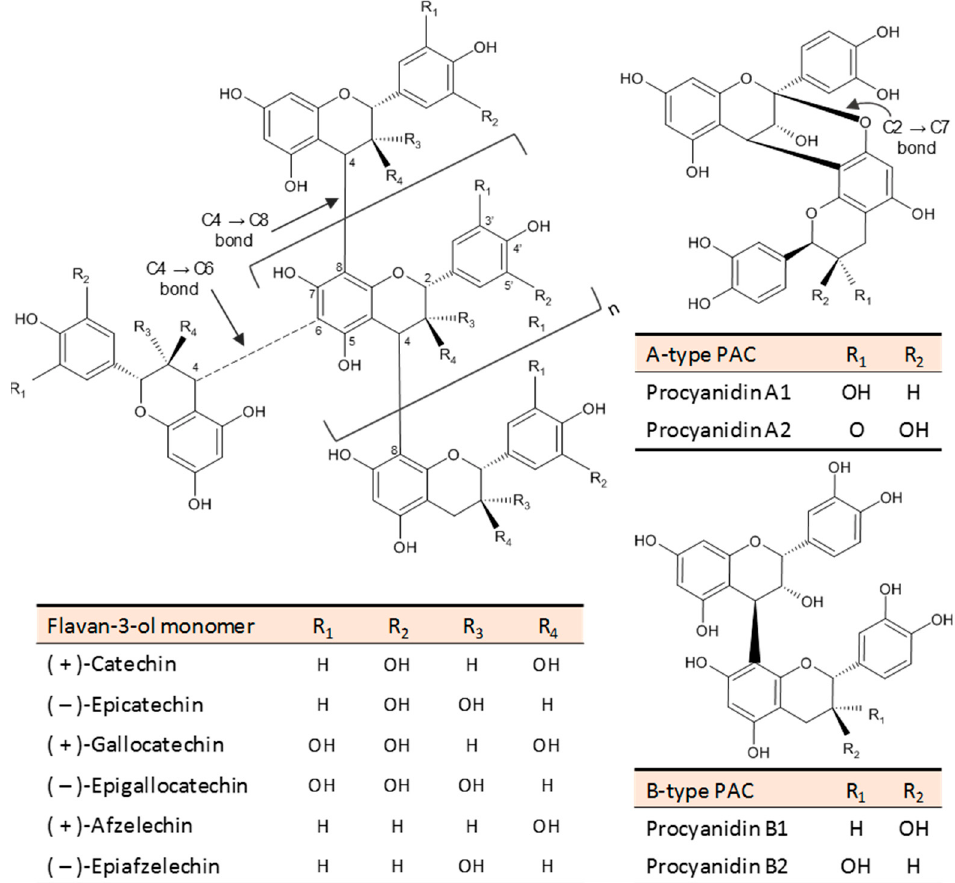
Figure 2. Chemical structures of proanthocyanidins (PACs). Flavan-3-ol monomers differ based on the hydroxylation pattern and their cis- or trans- configuration. Dimers A1/A2 and B1/B2 are shown as example of A- and B-type PACs, respectively.